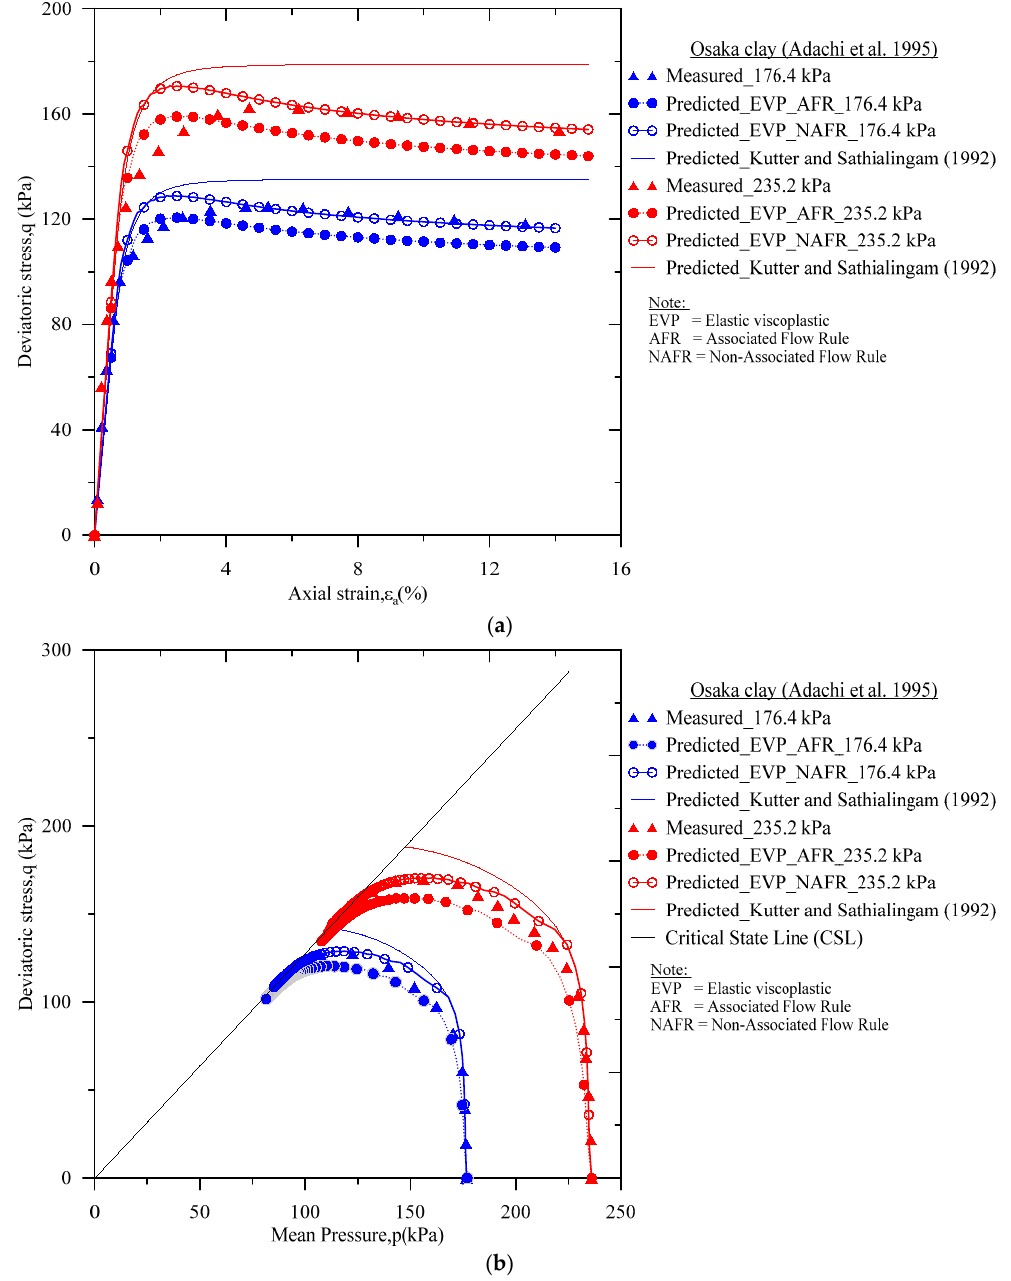
Figure 5. Comparison of the measured and the predicted consolidated undrained triaxial compression tests results for the Osaka clay: ( a ) the deviatoric stress vs. axial strain; and ( b ) the stress path. In Figure 5, the experimental results for the Osaka clay for two different mean pressures (176.4 kPa and 235.2 kPa) are compared with the non-associated flow rule type EVP model, and the EVP model developed by Kutter and Sathialingam [42]. In Figure 5-a, we can see that, for the mean pressure of 235.2 kPa, the new EVP model and the Kutter and Sathialingam [42] EVP model predictions were identical up to an axial strain of 1.87%. After this point, their model over-predicted was 16%, whereas the new EVP model captured the strain softening. On the other hand, at an axial